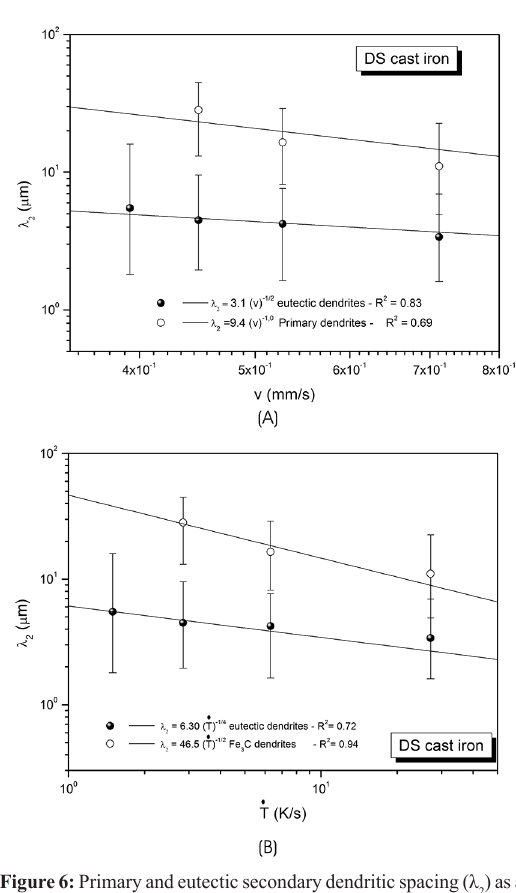
Figure 6: Primary and eutectic secondary dendritic spacing (λ function of (a) growth rate and (b) cooling rate for the directionally solidified cast iron. R 2 is the coefficient of determination.